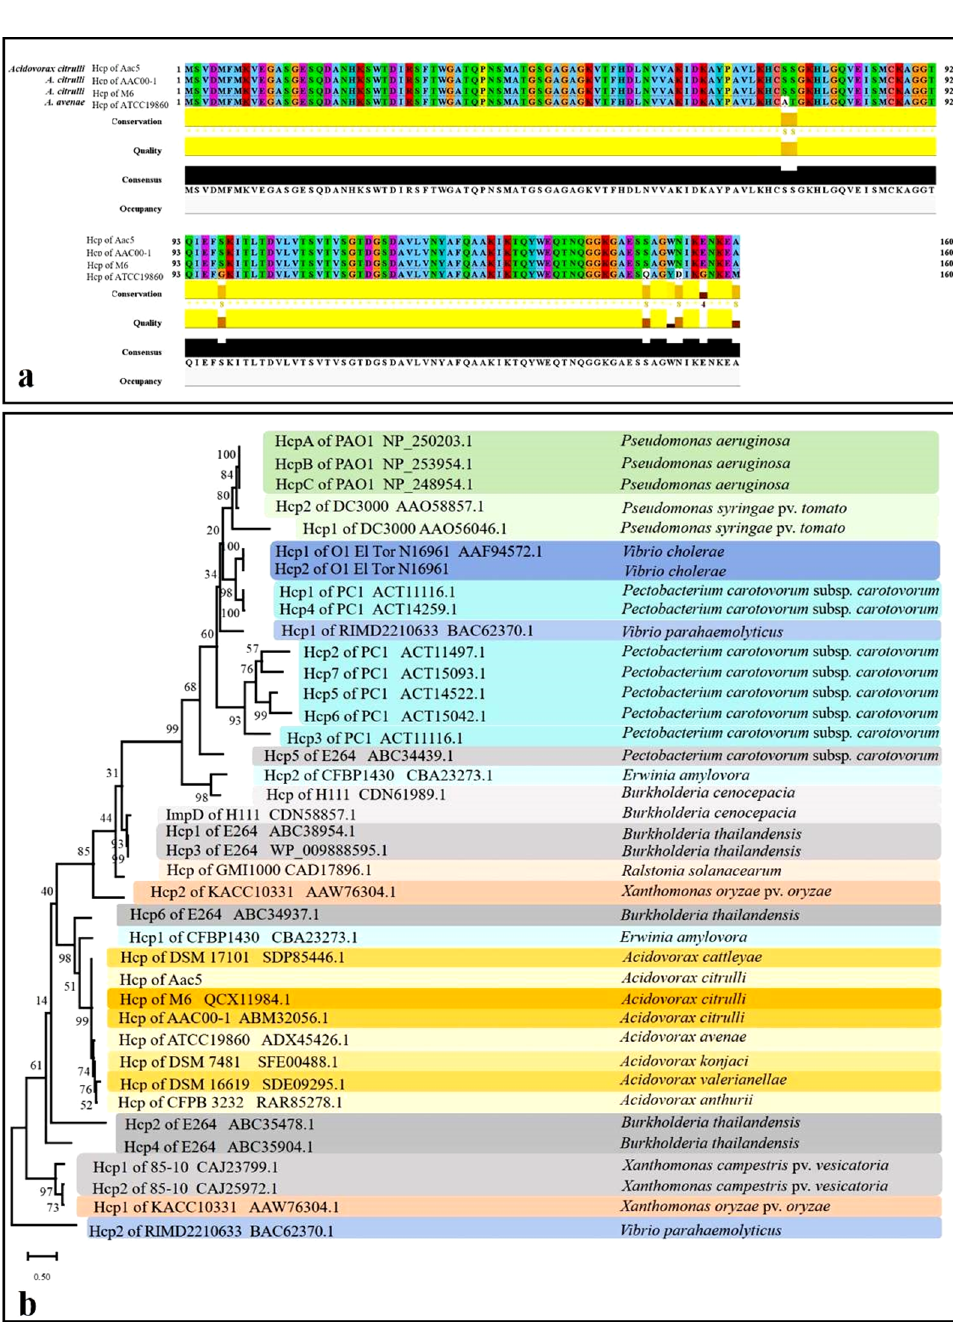
Figure 1. Sequence analysis of Hcp from Acidovorax citrulli Aac5. ( a ) Multiple sequence alignment of Hcp amino acid sequences from A. citrulli Aac5, AAC00-1, M6, and A. avenae ATCC19860. The alignment was performed using CLUSTALW2 and visualized in Jalview. ( b ) Maximum-likelihood phylogeny based on representative Hcp protein sequences. The evolutionary relationship was inferred in MEGA11 using the Maximum likelihood method and the JTT matrix-based model. The tree with the highest log likelihood ( − 8853.75) is shown. The bootstrap values are shown above the branches. Initial tree(s) for the heuristic search were obtained automatically by applying the Neighbor-Joining and BioNJ algorithms to a matrix of pairwise distances estimated using the JTT model and then selecting the topology with superior log-likelihood value. The tree is drawn to scale, with branch lengths measured in the number of substitutions per site. The tree was rooted with the outgroup Hcp2 of RIMD2210633 BAC62370.1, which has relatively low homology with other Hcps.